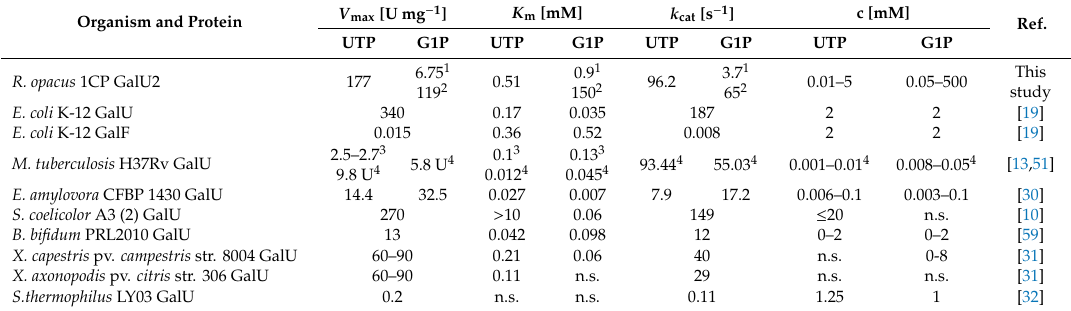
Table 2. Kinetic properties of UDP-glucose pyrophosphorylases used for the phylogenetic analysis. Units are given in brackets in the table head, unless otherwise